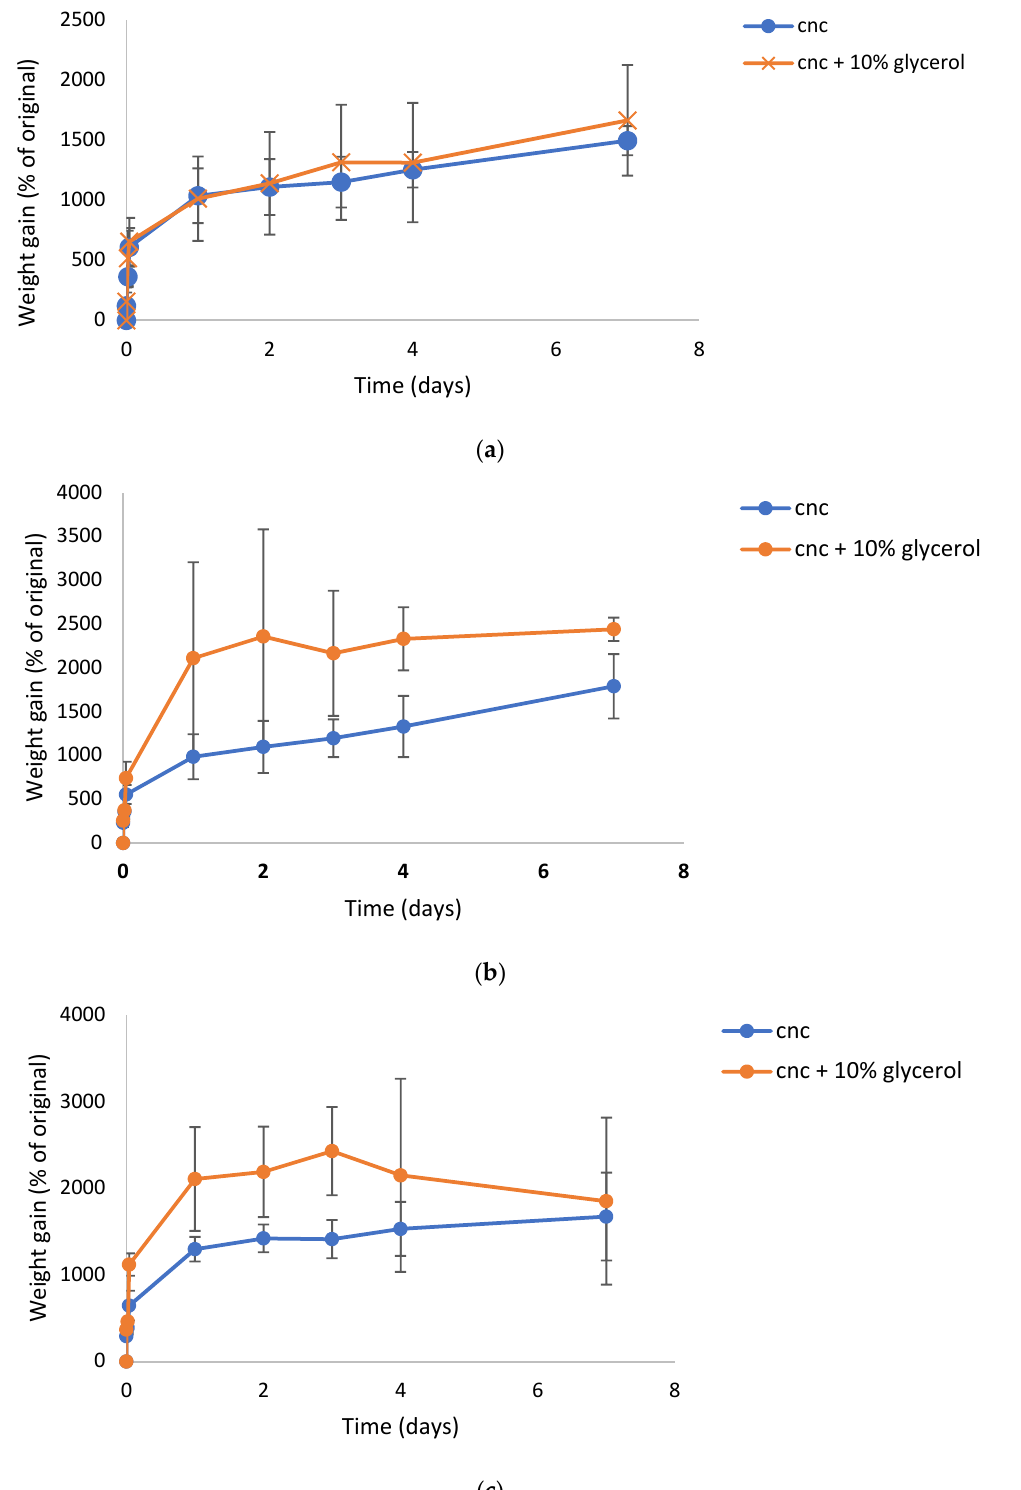
Figure 3. ( a ) Time course of swelling of silver nitrate loaded CNC hydrogel films in water. ( b ) Time course of swelling of silver sulphate loaded CNC hydrogel films in water. ( c ) Time course of swelling of silver acetate loaded CNC hydrogel films in water.